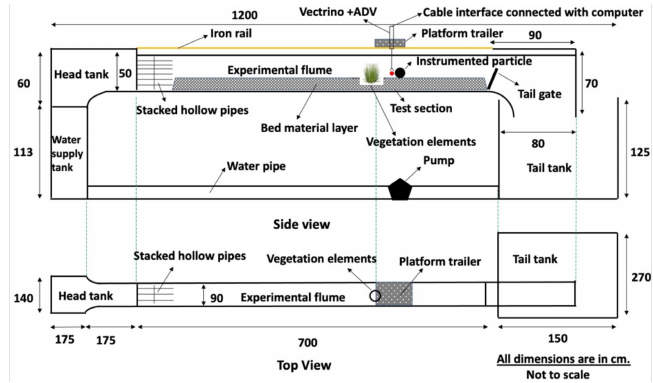
Figure 2. Schematic diagram of the side and top views of the experimental flume. Vertical green dashed lines denote the corresponding components between the two views.